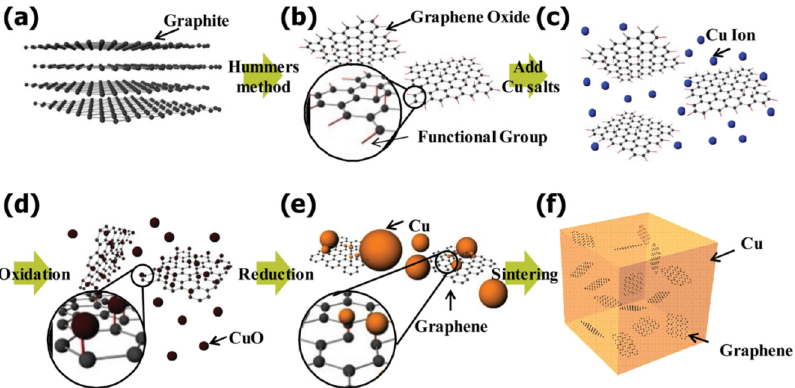
Figure 5. Schematic of the preparation method of RGO/Cu nanocomposite: ( a ) pristine graphite; ( b ) graphene oxide by the Hummers method; ( c ) dispersion of copper salt in graphene oxide solution; ( d ) oxidation of copper ions to copper-oxide on graphene oxide; ( e ) reduction of copper-oxide and graphene oxide; ( f ) sintered RGO/Cu nanocomposite powders, reproduced from [71], with permission from John Wiley and Sons, 2018.